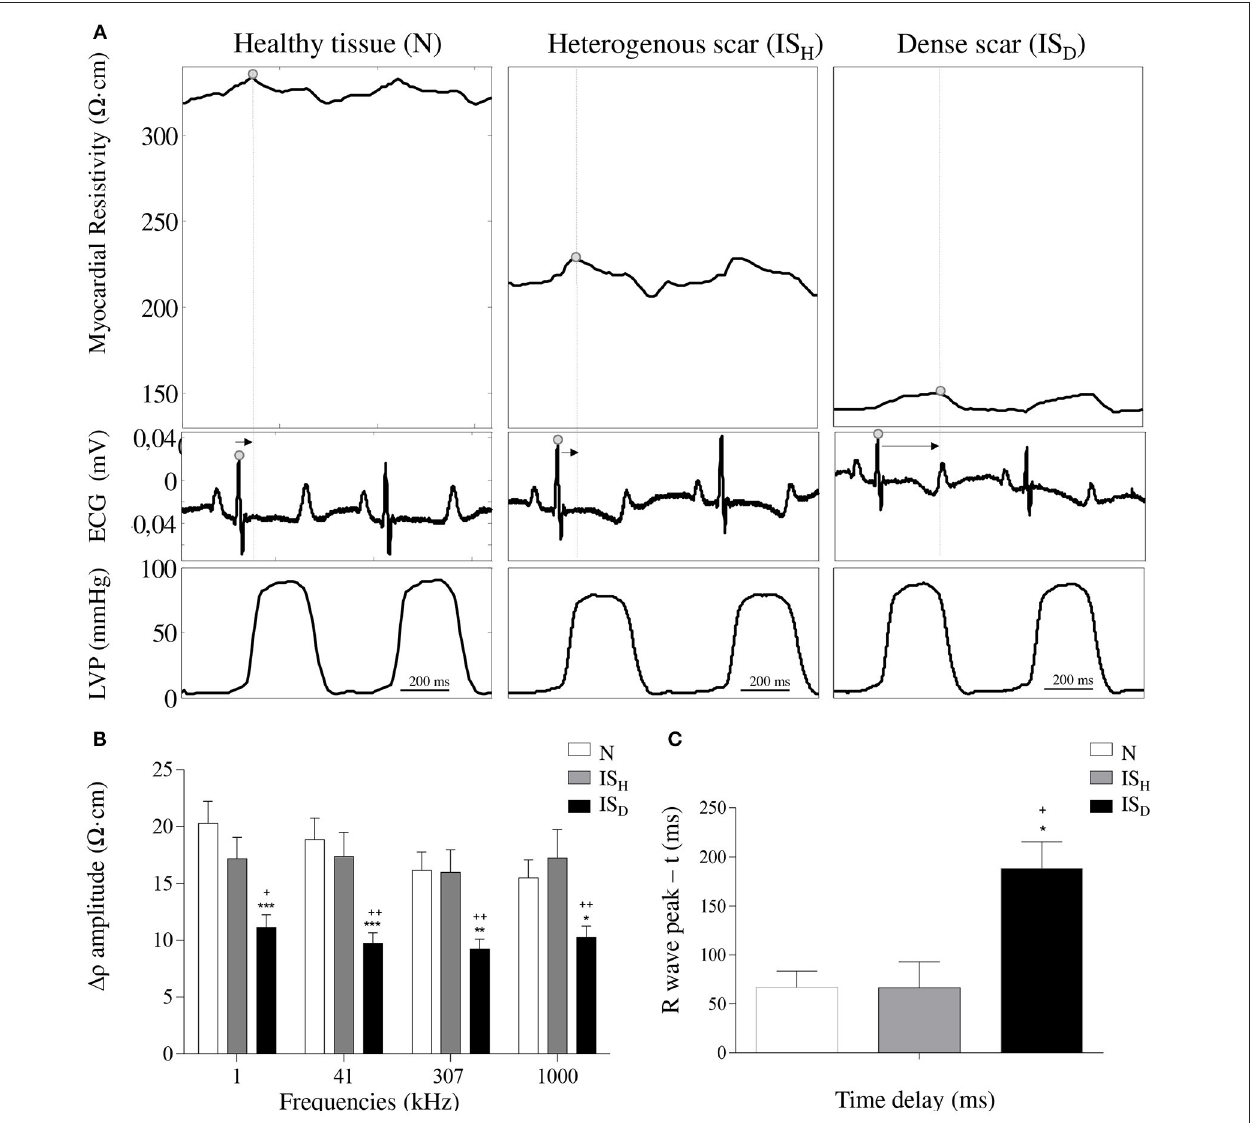
FIGURE 5 | Effects of infarct fibrotic content on myocardial resistivity curve. (A) Systolic-diastolic myocardial resistivity waveform in healthy myocardial tissue (left), heterogeneous scar (middle) and dense scar tissue (right). Arrows indicate the time interval between the R wave peak and the max peak of the resistivity curve. (B) Mean values of the systolic-diastolic resistivity curve amplitude - 1 ρ - at 4 selected frequencies (1kHz, 41kHz, 307kHz, 1000kHz). (C) Mean temporal delays between the peak of the systolic-diastolic resistivity curve and its corresponding R wave peak of the ECG. Resistivity waveforms and delays are shown at 41kHz. * Significantly different from N (* < 0.05, ** < 0.01, *** < 0.001). + Significantly different from IS H ( + < 0.05, ++ <